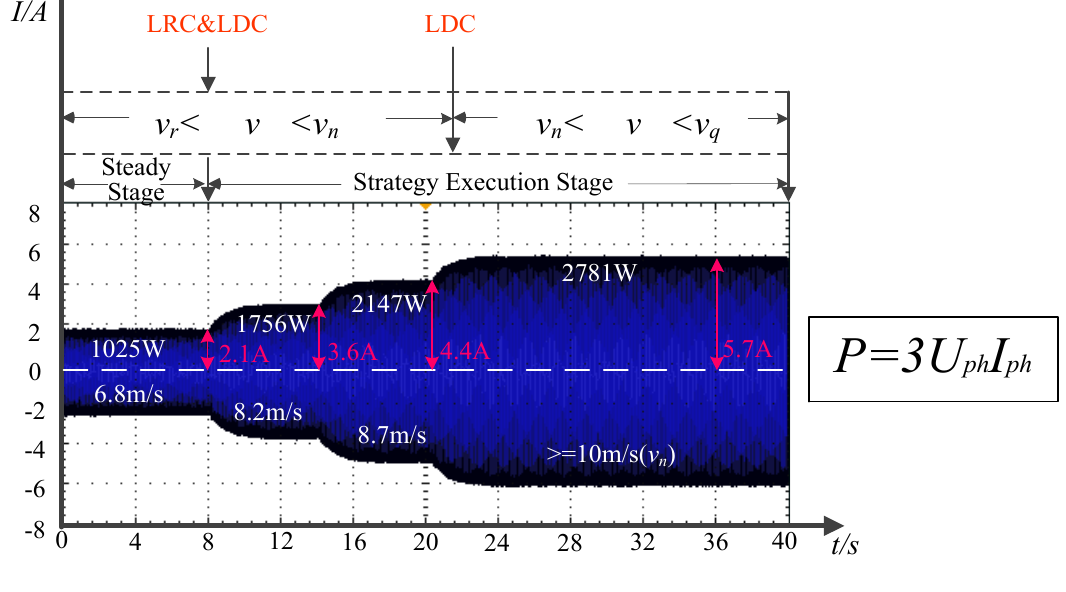
Figure 9. Generation of WTSS in Scenario